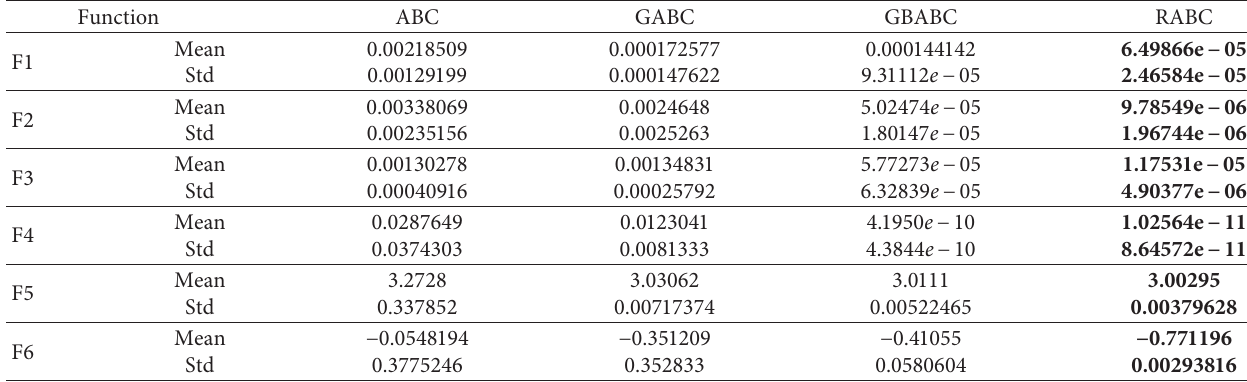
Table 2: Benchmark function experimental